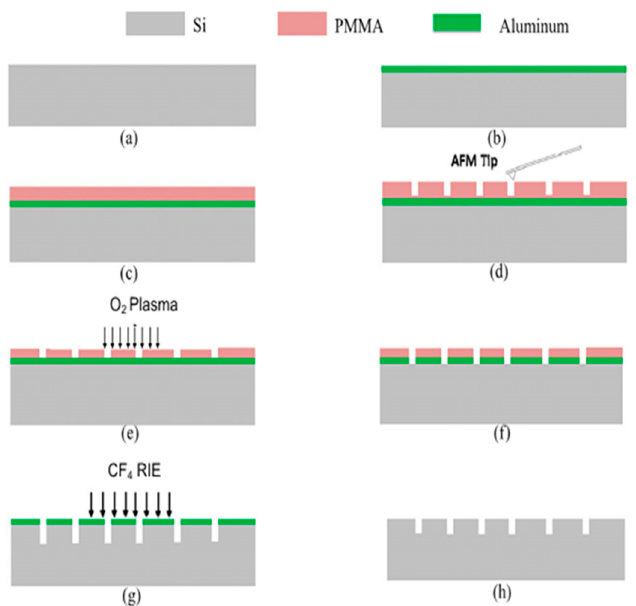
Figure 16. The transfer procedures of nanostructures formed by the TBN method using reactive ion etching (RIE): ( a ) starting from cleaned silicon substrate, ( b ) aluminum deposition on silicon substrate, ( c ) polymethyl methacrylate (PMMA) spin-coating on aluminum layer, ( d ) machining patterns on PMMA, ( e ) PMMA etching in O 2 plasma till aluminum layer surface is exposed, ( f ) aluminum etching to create mask, ( g ) silicon etching using reactive ion beam etching (RIE), ( h ) aluminum mask stripping and sample surface cleaning [52] .